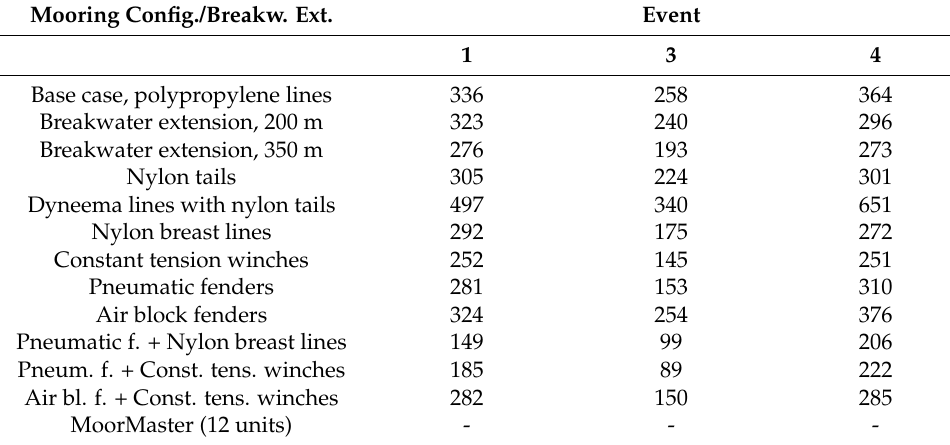
Table 12. Maximum forces in spring lines (kN).